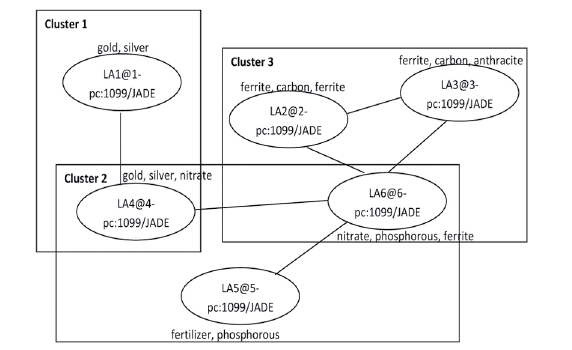
Fig. 2. Peer clustering and overlay organisation achieved using la- tent semantic